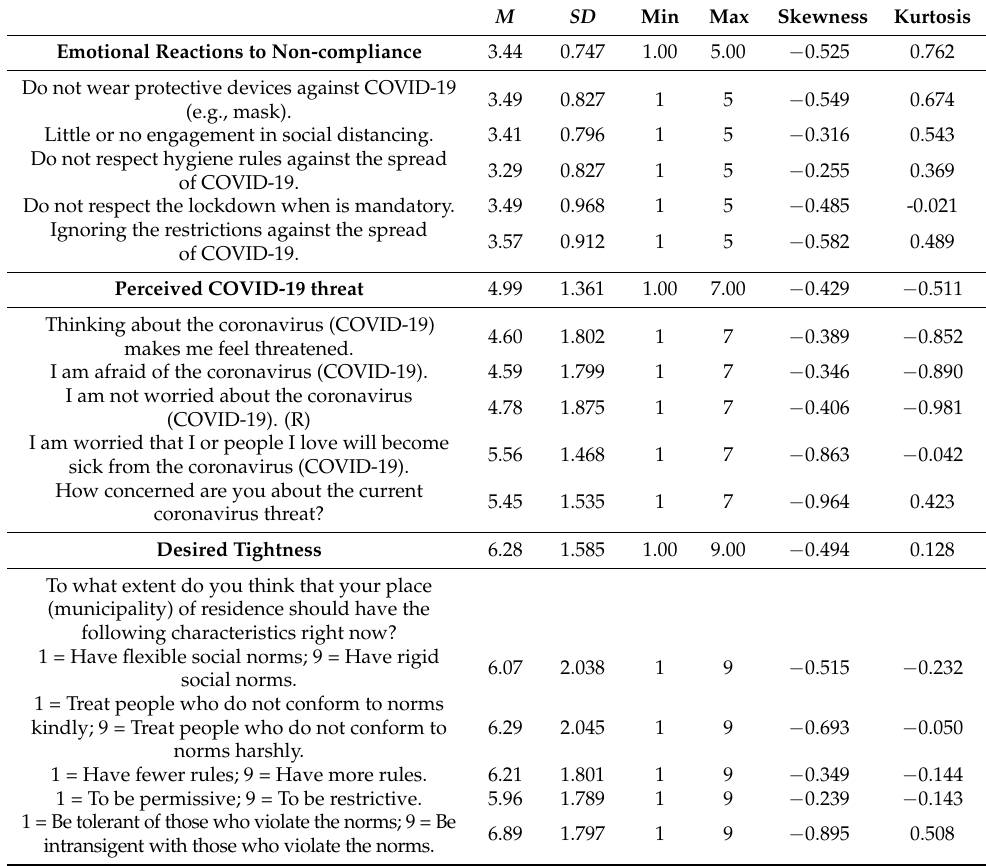
Table 2. Items and descriptive statistics of the Perceived COVID-19 threat, Desired Tightness and Emotional Reactions to Non-compliance with COVID-19 Health-protective Behaviors. M SD